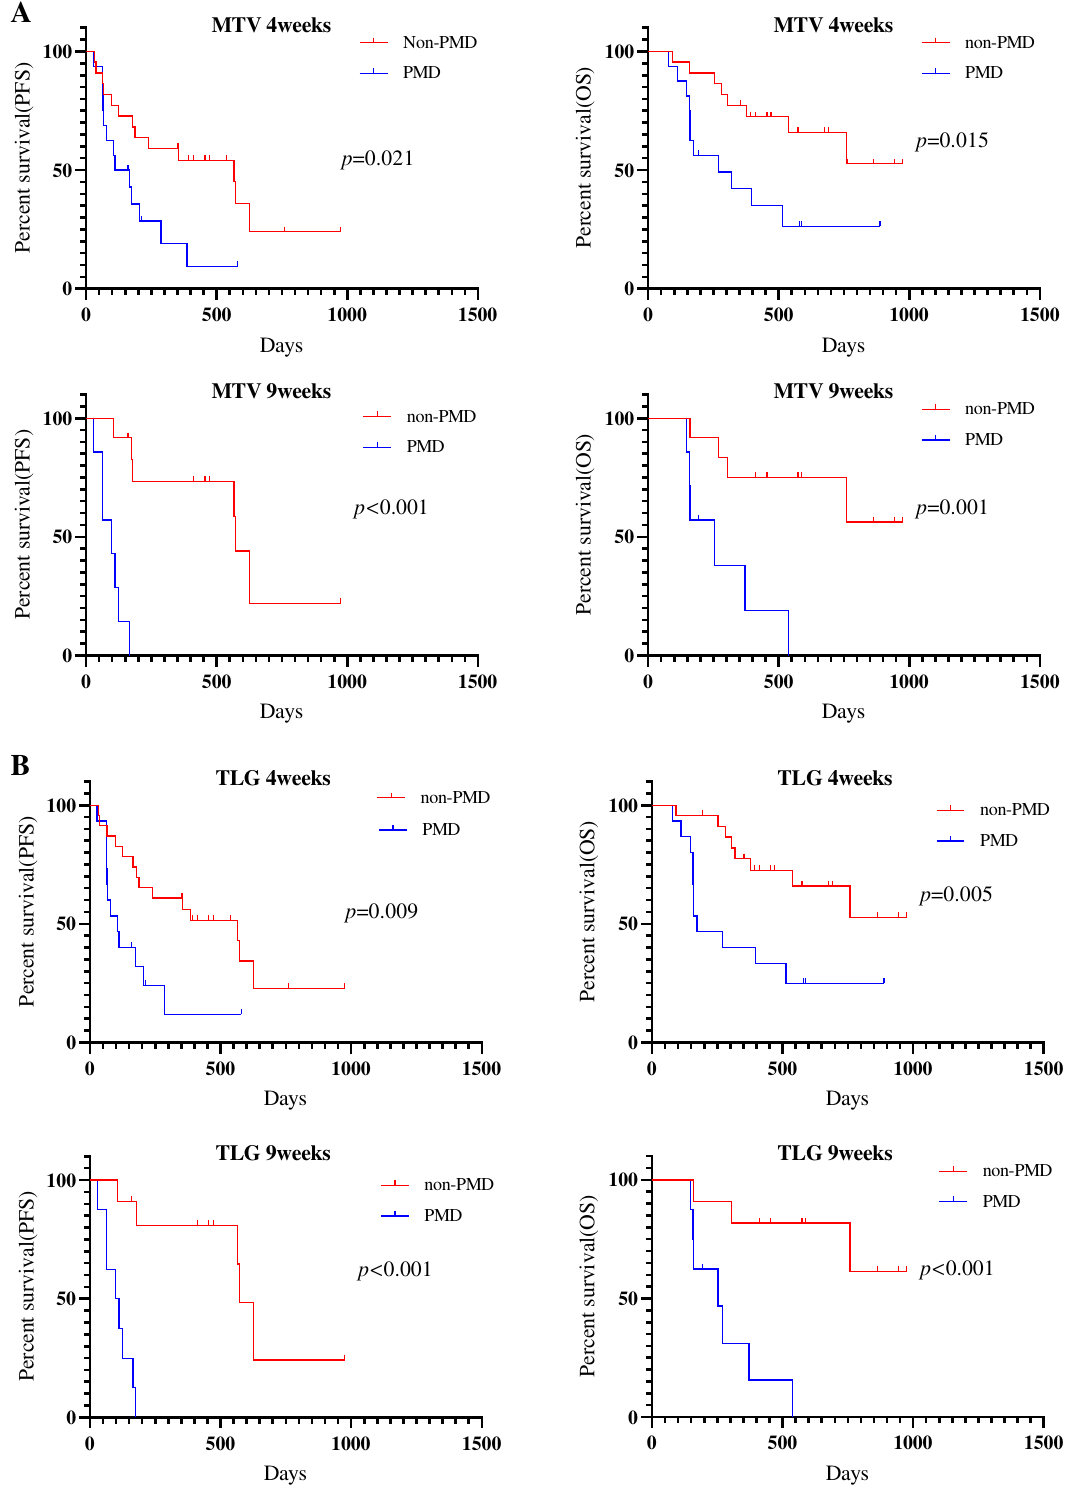
Figure 3. Kaplan–Meier curve of PFS and OS according to 18 F-FDG uptake at 4 and 9 weeks in 38 patients with SD on CT scan at 4 weeks after PD-1 blockade initiation. A significant difference in PFS and OS was noted between PMD and non-PMD based on MTV ( A ) and TLG ( B ) at 4 and 9 weeks, but not SUL max at 4 and 9 weeks ( C ). A significant difference in the PFS and OS according to SUL peak at 9 weeks was observed between PMD and non-PMD, but no at 4 weeks ( D